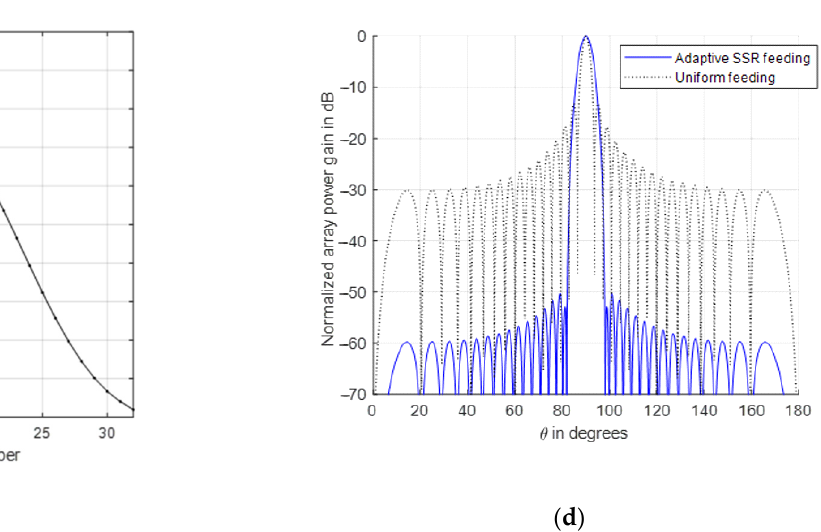
Figure 5. An adaptive SSR algorithm for 32-element array to achieve − 50 dB: ( a ) adaptive damping factor variation versus the loop number, ( b ) development of reduced SLL radiation pattern with key loop numbers, ( c ) final array weighting coefficients, and ( d ) final normalized array power pattern compared to uniform feeding.